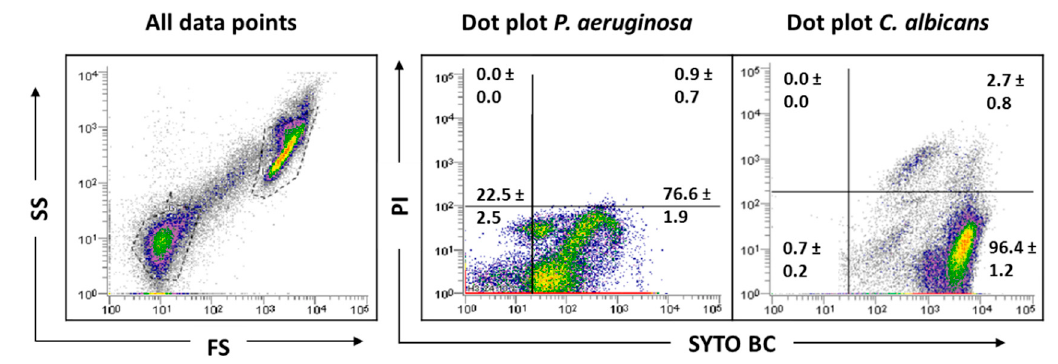
Figure 5. Representative dot plots obtained for P. aeruginosa PAO1 and C. albicans 547096 mixed-species biofilms by FCM. In ‘all data points’, the dot plots SS (Side Scatter) × FS (Forward Scatter) are represented, as acquired in the logarithm. Dot plots of P. aeruginosa and C. albicans represent the areas delineated to represent bacteria and fungi, respectively.